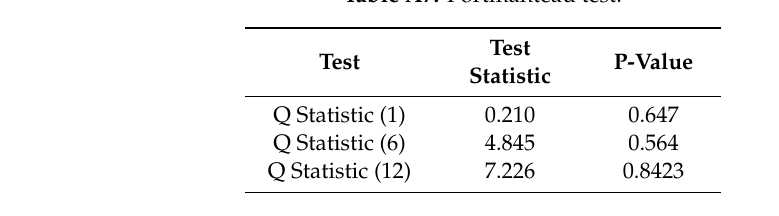
Table A7. Portmanteau test.